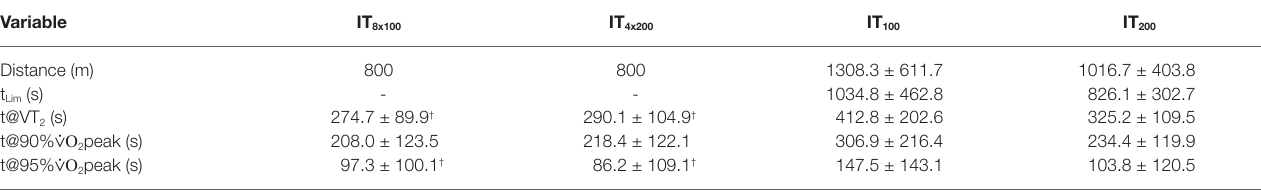
TABLE 4 | Mean ± SD of the distance and time performance during the IT protocols ( N = 12). Variable IT 8x100 IT 4x200 IT 100 Distance